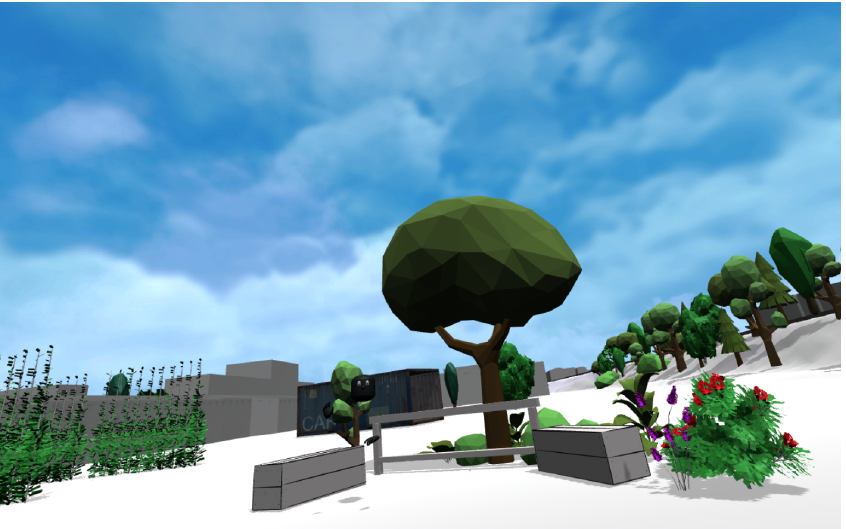
Figure 3. Each co-user is shown as an avatar with a head and hands, allowing simple gestures like pointing, thumb up or